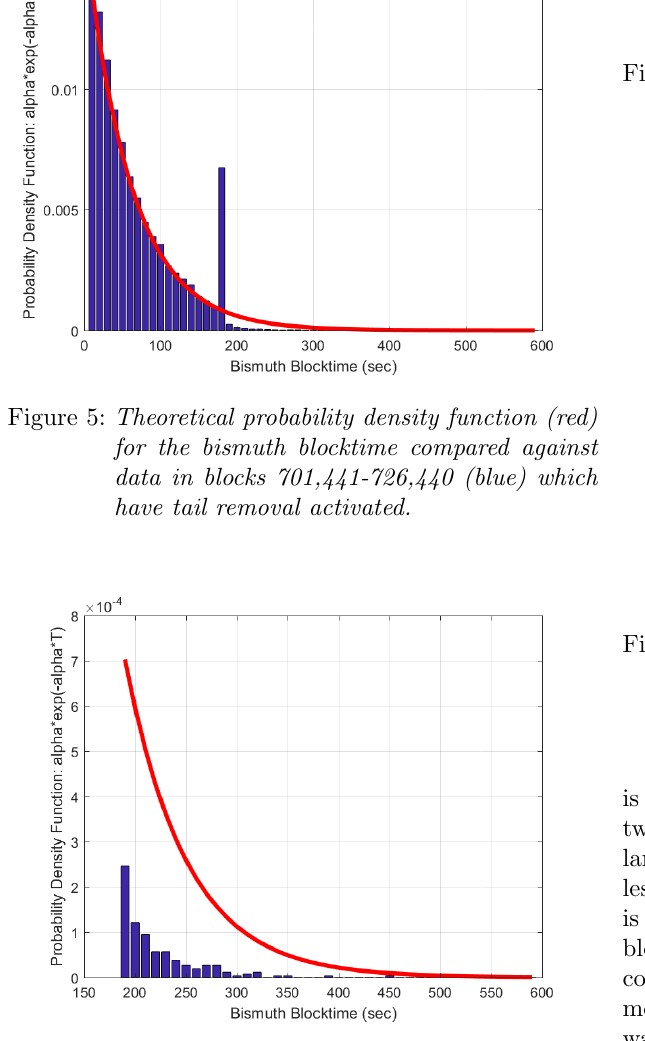
Figure 6: Theoretical curve (red) vs. Bismuth block- times larger than 180 seconds in blocks 701,441-726,440 (blue).